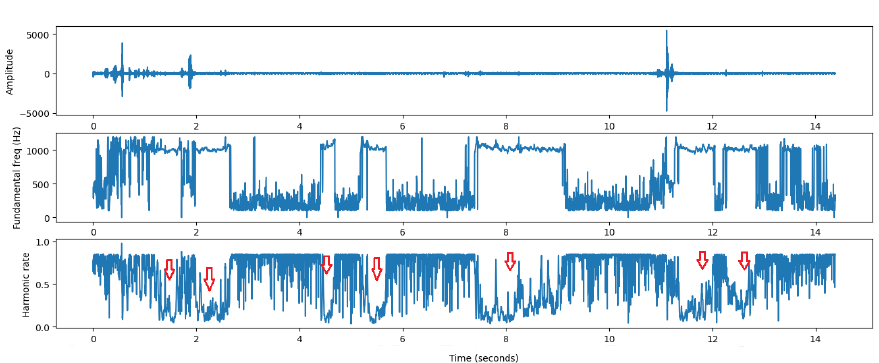
Figure 19. Fundamental frequency estimation and harmonic rate value using pYin algorithm for mosquito counting (red